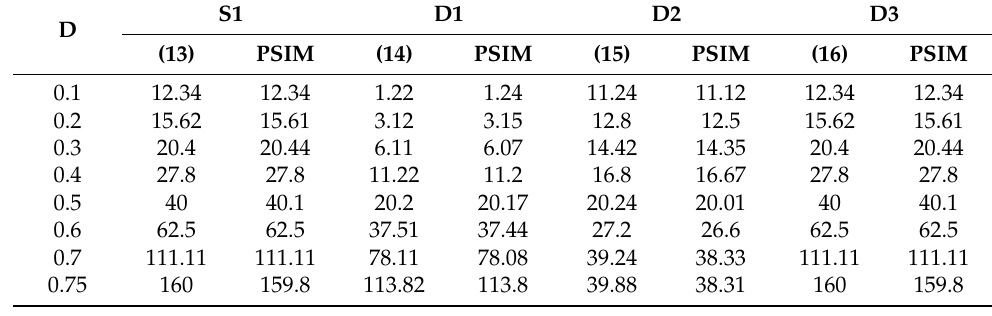
Table 1. Voltage stresses across different components at different duty-cycles.